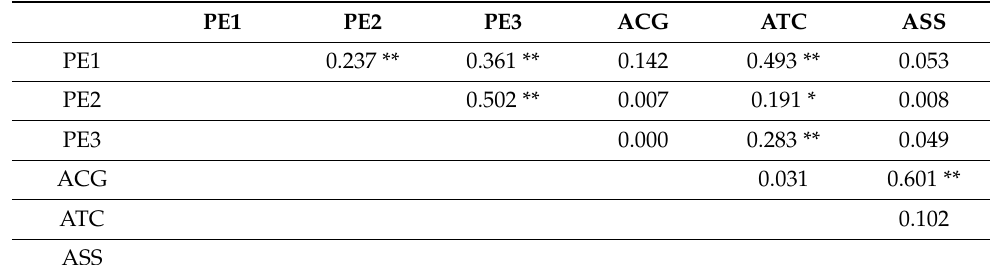
Table 2. Preliminary